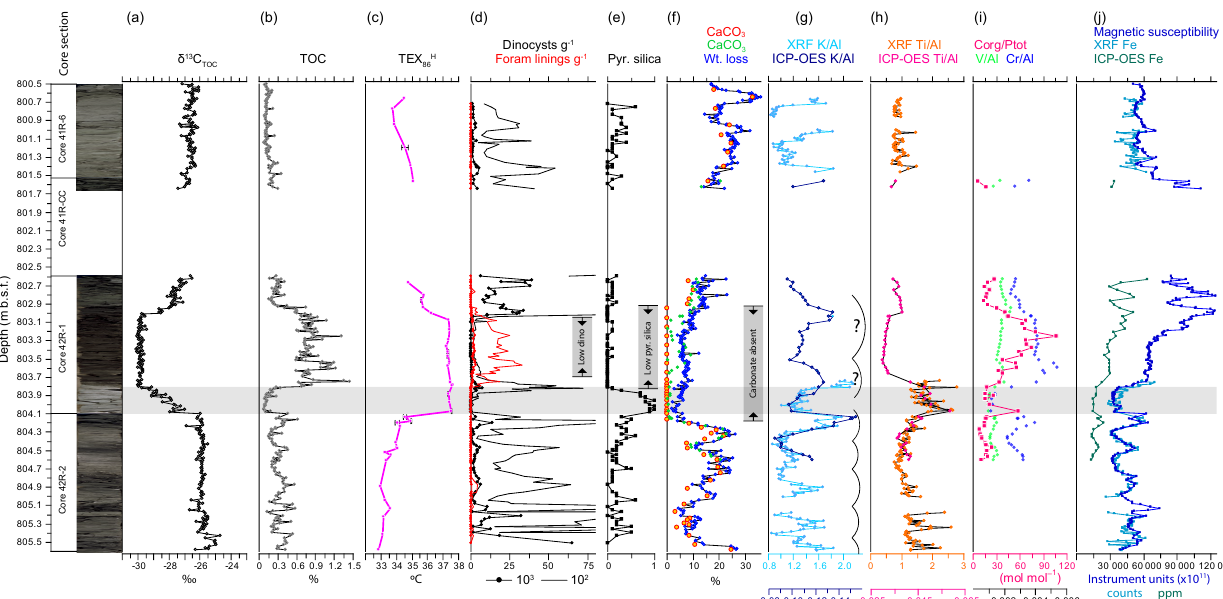
Figure 3. The PETM as recorded with organic and inorganic geochemical proxies at Site 959. (a) δ 13 C TOC in per mill. (b) Total organic carbon (TOC) in weight percentages. (c) TEX H derived temperature. (d) Dinoflagellate cyst and organic linings of benthic foraminifera 86 (ng − 1 of dry sediment, where ”n” represents the number of specimens). (e) Fraction of pyritized silica particles in palynological residue. (f) Weight loss during decalcification (wt. loss) as indication of CaCO 3 content; CaCO 3 calculated from Ca concentration ICP-OES (green) and selected samples analyzed for CaCO 3 on a coulometer (orange). (g) K / Al ratio from XRF (light blue) and ICP (dark blue). (h) Ti / Al ratio from XRF (orange) and ICP-OES (pink). (i) Cr / Al (blue), V / Al (light green), and C org / P tot ratios (pink) in moles per mole. (j) Mag- netic susceptibility in instrument units ( × 10 11 ; dark blue), XRF Fe counts (light blue), and ICP-OES Fe concentrations in parts per million (green). The gray band (804.1–803.83mb.s.f.) marks the porcellanite. δ 13 C TOC , TOC, and TEX H data from Frieling et al. 86